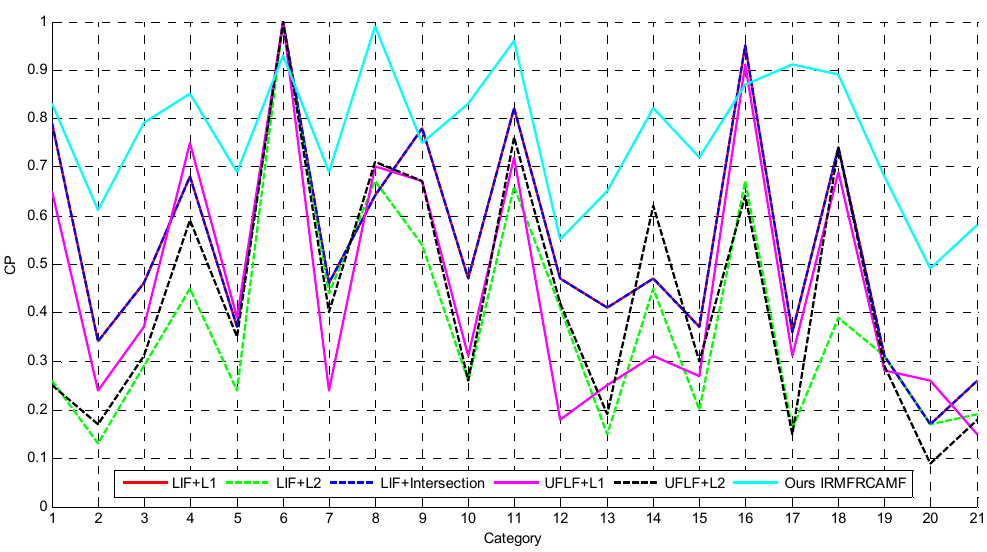
Figure 8. Class-level precision (CP) among different methods.